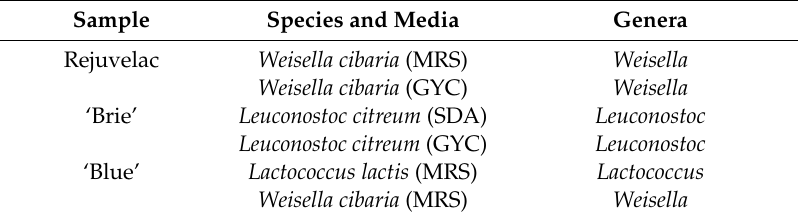
Table 2. Comparison of species sequenced from cultured isolates vs. genera sequenced from microbiota